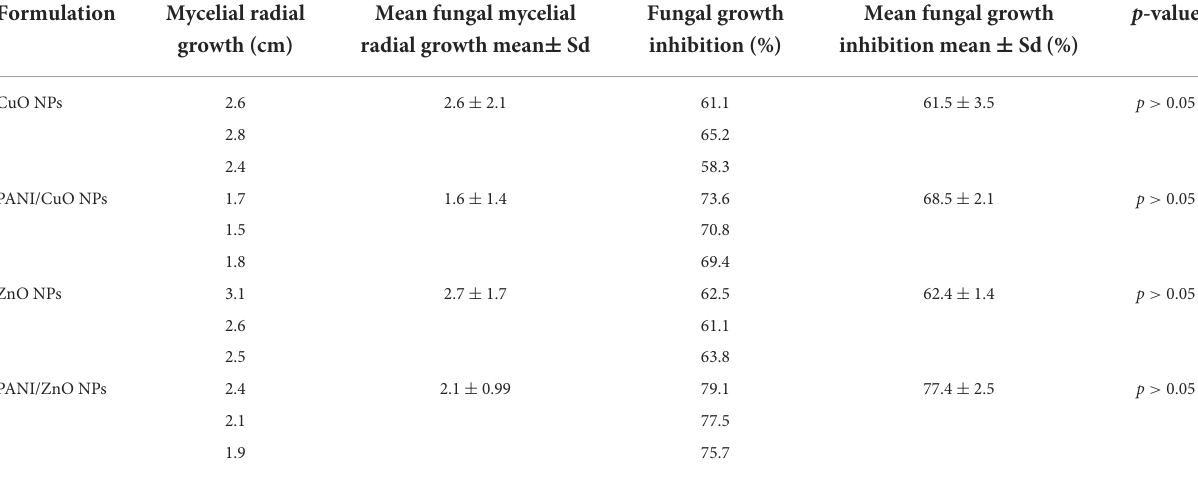
TABLE 1 Mycelial diameter (cm) and fungal growth inhibition (%) by CuO, PANI/CuO, ZnO, and PANI/ZnO nanoparticles against A. parasiticus after 72h of incubation and 12 mmol L − 1 concentration.